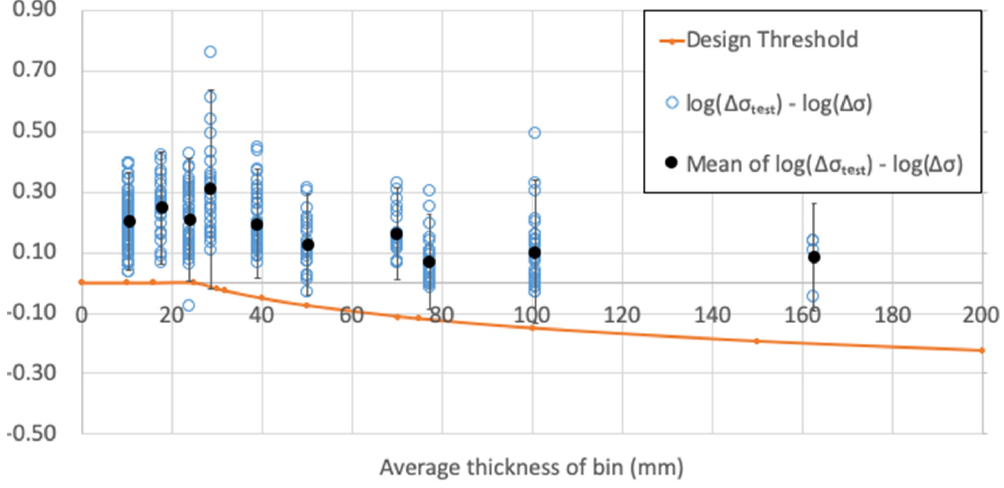
Figure 8. Data analysis of in-air T-joints .